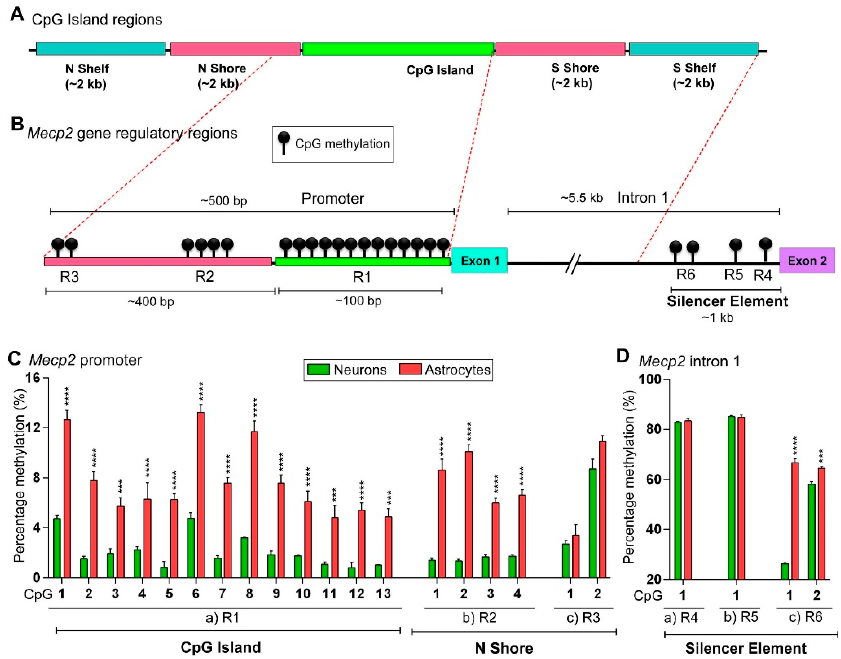
Figure 3. Bisulfite pyrosequencing analysis of DNA methylation at the Mecp2 regulatory elements (REs) in male neurons and male astrocytes. ( A ) Schematic representation of CpG island regions characterized based on distribution of CpGs. Part A of the figure is modified from [34,35] (not drawn to scale). ( B ) Location of CpGs in Mecp2 gene REs. Figure not drawn to scale. The figure illustrates the six previously reported REs [17], R1–R3 promoter Res, and R4–R6 intron 1 silencer element REs (not drawn to scale). The methylation symbol indicates the number of CpGs found within each RE: R1: 13 CpGs, R2: 4 CpGs, R3: 3 CpGs, R4: 1 CpG, R5: 1 CpG, and R6: 2 CpGs. ( C ) Percentage of DNA methylation (%) of CpG sites within the Mecp2 promoter regions (a) R1, (b) R2, and (c) R3. ( D ) Percentage of DNA methylation (%) of CpG sites within the Mecp2 intron 1 regions (a) R4, (b) R5, and (c) R6. Significant di ff erences between male neurons and male astrocytes are indicated with **** p < 0.0001, *** p < 0.001, N = 3 ± SEM.